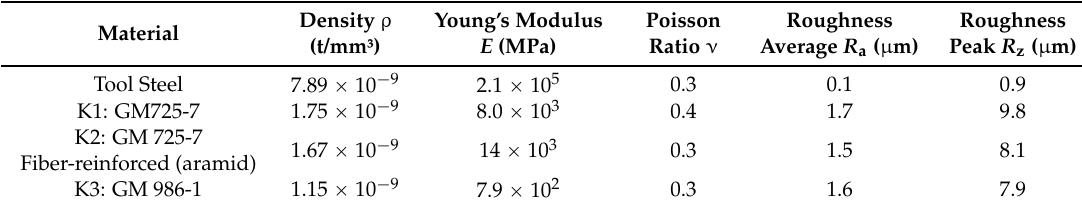
Table 2. Material properties of different tool materials used in investigations